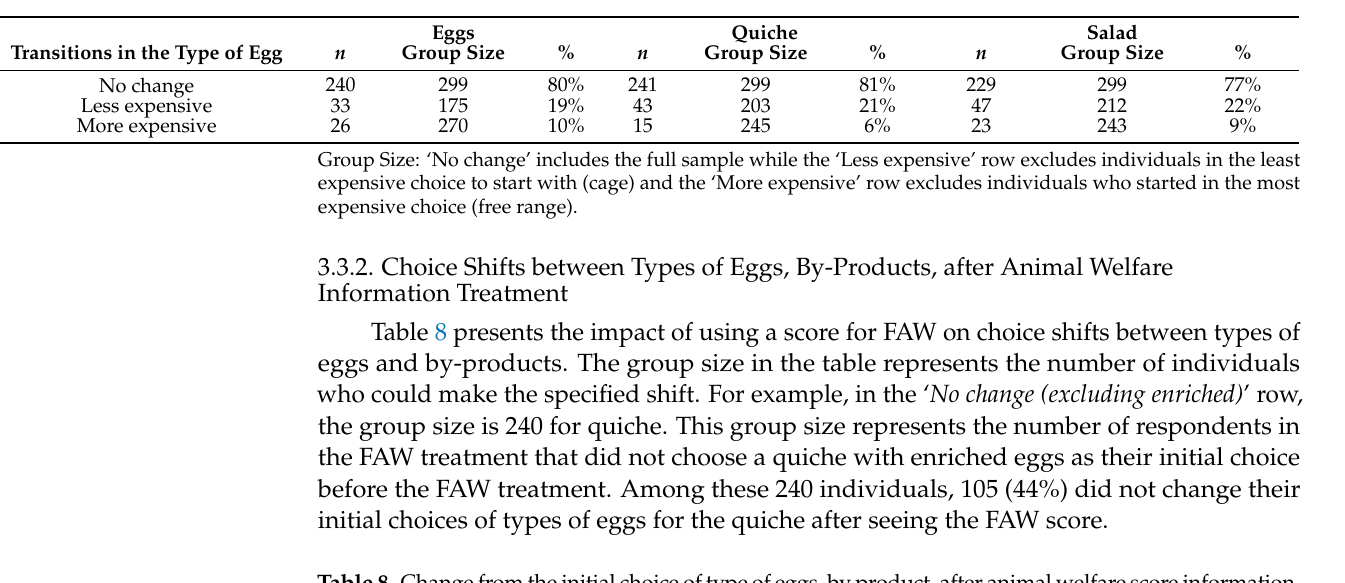
Table 8. Change from the initial choice of type of eggs, by product, after animal welfare score information.